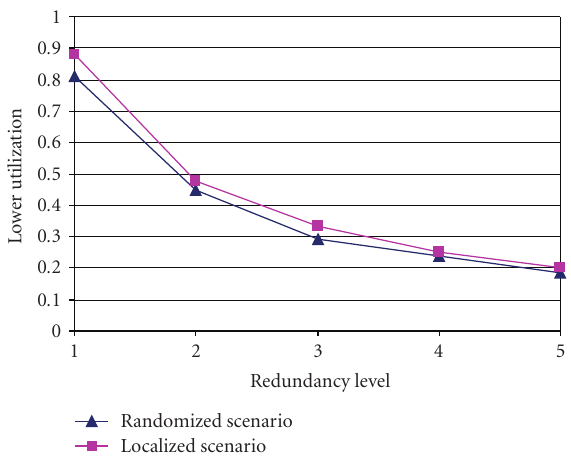
Figure 6: Lower Utilization—Heavily Loaded Network.